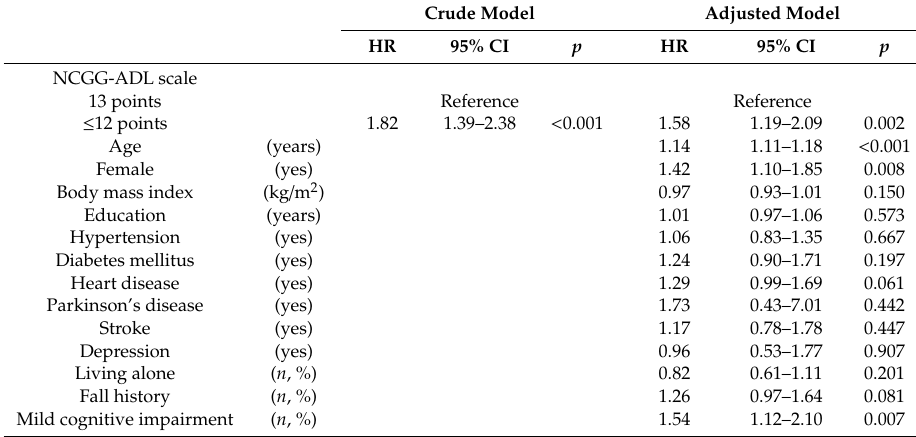
Table 3. Hazard ratios and 95% confidence intervals for disability incidence in the crude and adjusted models for 24 months per the cut-o ff points (12 / 13 points) of the NCGG-ADL scale ( N = 2708). Crude